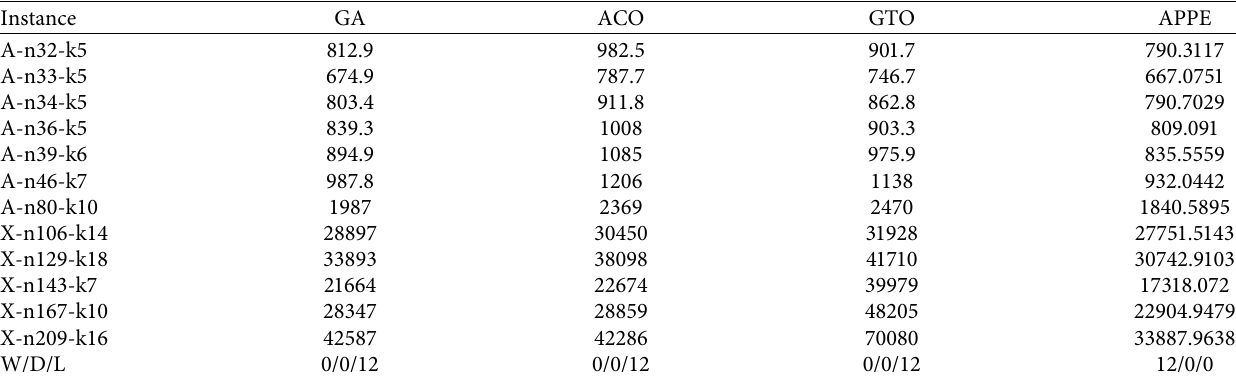
Table 19: Comparison of the mean result of 10 runs of APPE with the algorithms in Khairy et al.